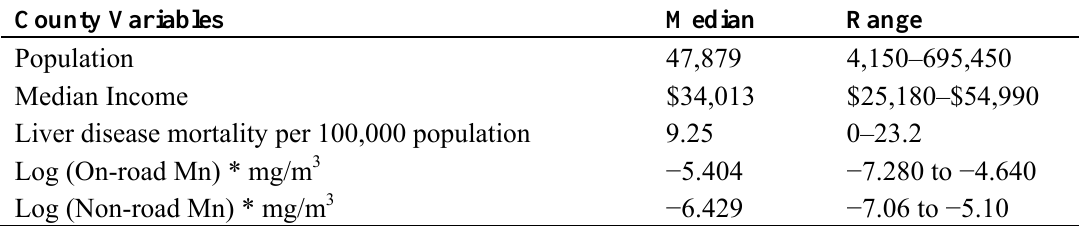
Table 1. North Carolina county-level variables of demographic, liver mortality and manganese air concentrations on and off roads.